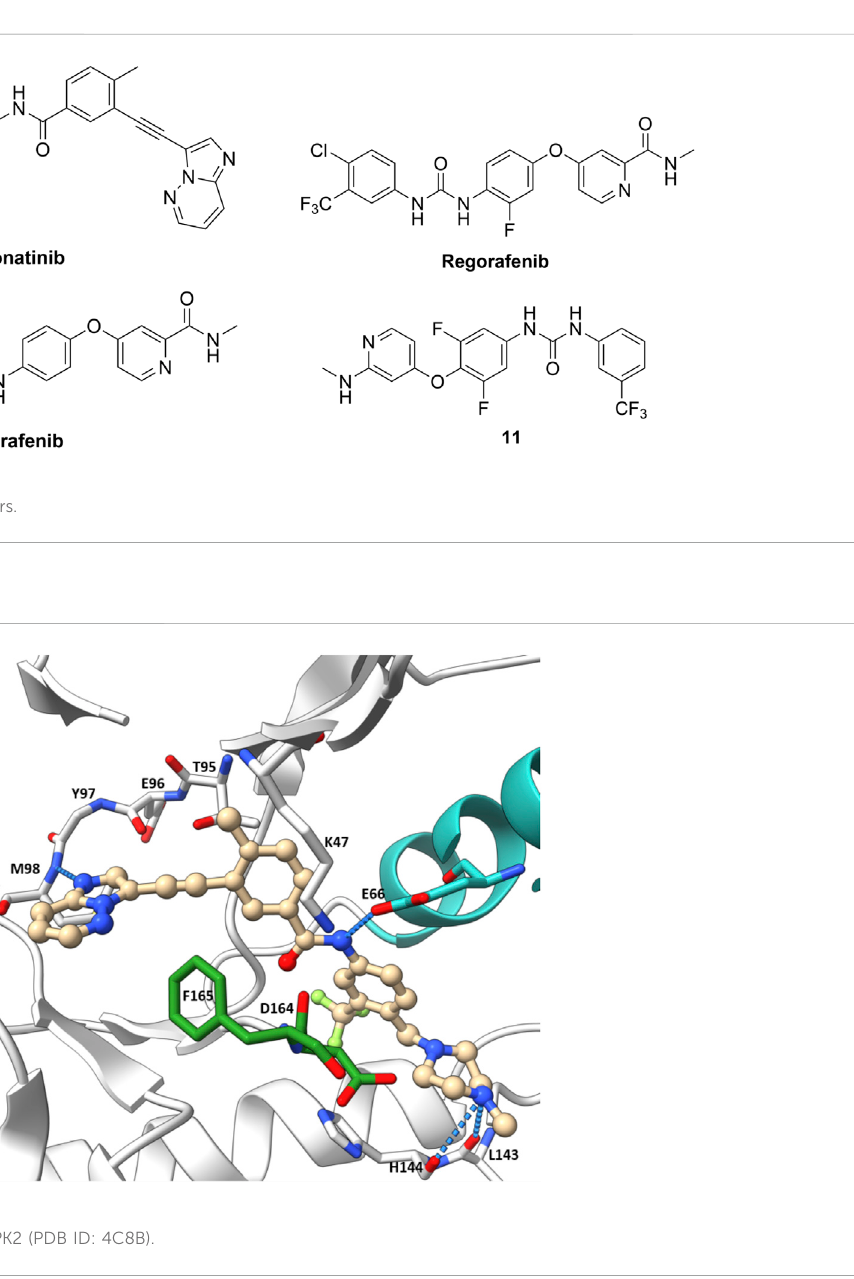
substituents at 3-position provided compound 10 with